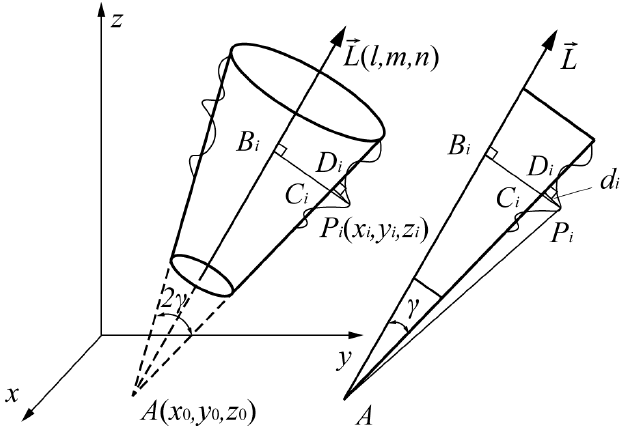
Figure 6. Cone in 3D coordinate system. It can be seen that d i is a function of variables ( x 0 , y 0 , z 0 , q 1 , q 2 ). Therefore, the objective function of PSO is